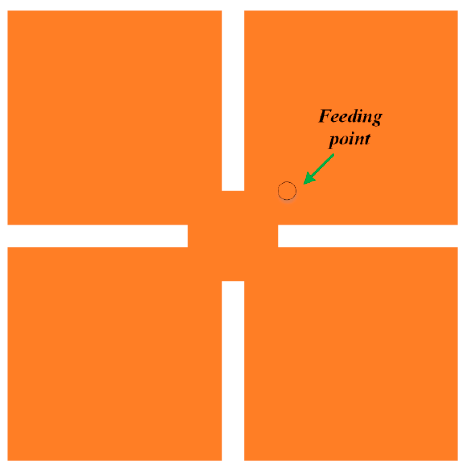
Figure 9. Dual-band antenna geometry.